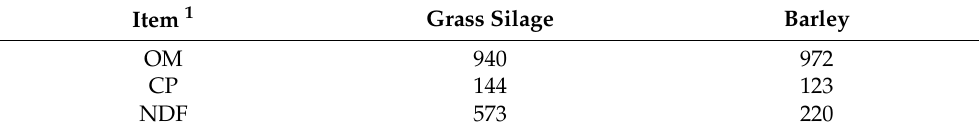
Table 1. Mean chemical composition (g/kg DM) of substrates used in the gas in vitro incubations. Item 1 Grass Silage Barley OM 940 972 CP 144 123 NDF 573